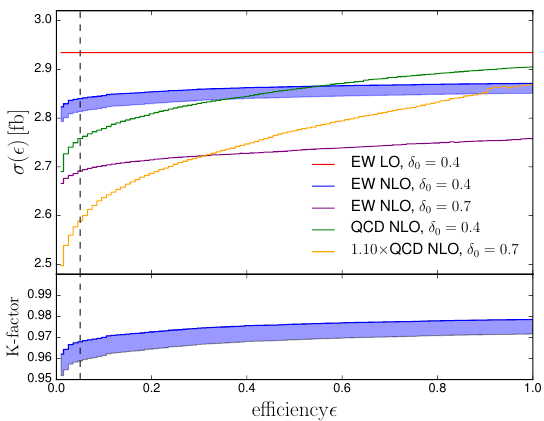
Figure 6 . Dependence of the total cross section on the photon isolation parameter (cid:15) for di(cid:11)erent sizes of the cone size (cid:14) 0